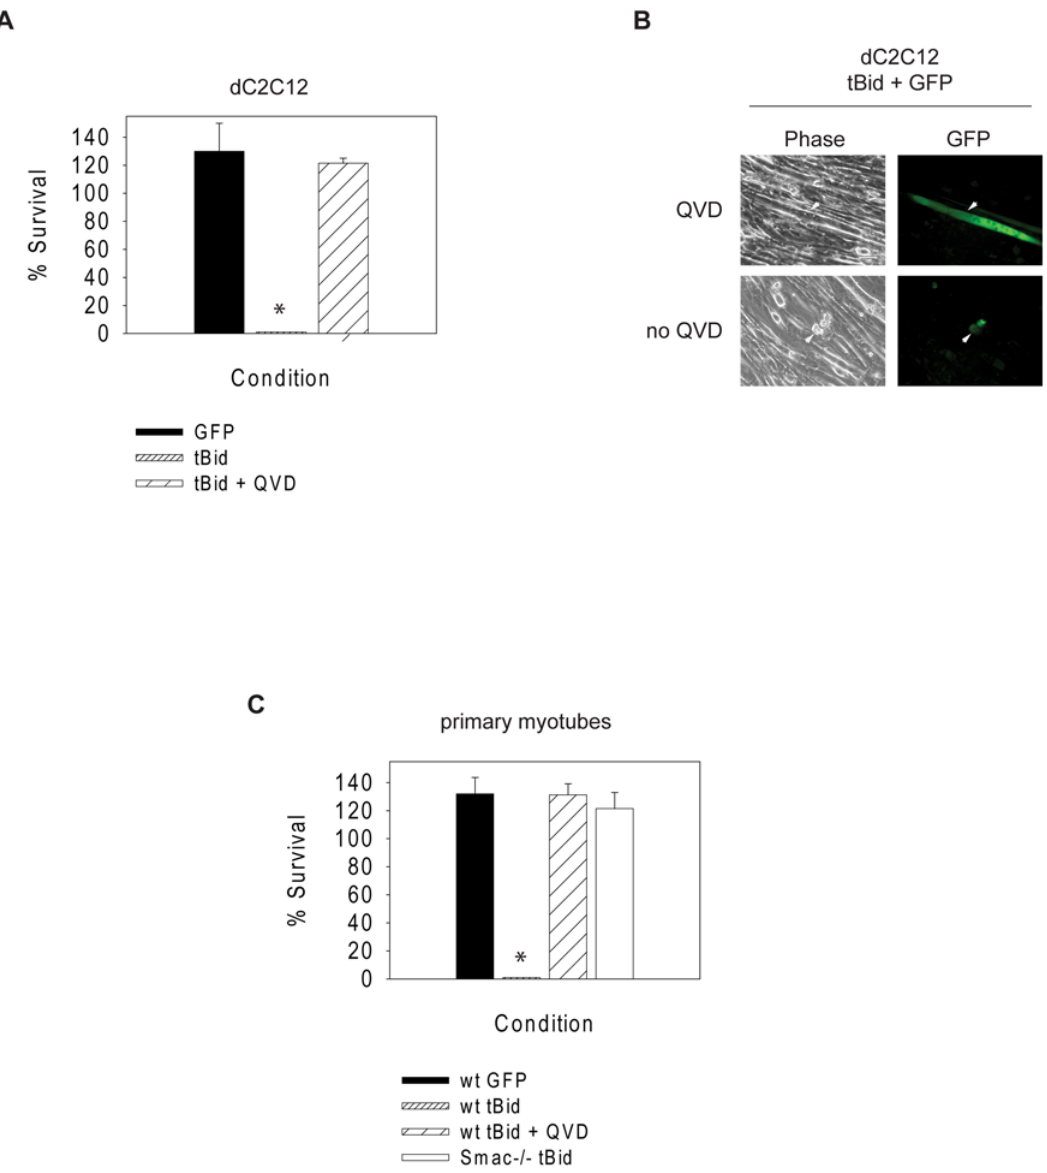
Figure 4. tBid causes caspase inhibitable death in myotubes that requires endogenous Smac. (A) dC2C12 were injected with plasmids for tBid or empty vector as well as GFP in the presence or absence of Q-VD-OPH (QVD). GFP expressing cells were counted 8 h and 24 h following injection. Percent survival was expressed as the percent of cells at 8 h that remained alive at 24 h following injection. Cell survival was assessed by morphology. Asterisk indicates that the actual survival was 0 %. (B) Photographs of dC2C12 cells eight hours following injection with tBid and GFP in the presence or absence of Q-VD-OPH (QVD). Arrows point to injected cells. Scale bars represent 50 m m. (C) Wild type (wt) and Smac-deficient (Smac-/-) primary myotubes were injected as described and assessment of survival was the same as in (A). Asterisk indicates that the actual survival was 0 %. Data are the mean 6 SEM of n $ 3 separate experiments per time point.